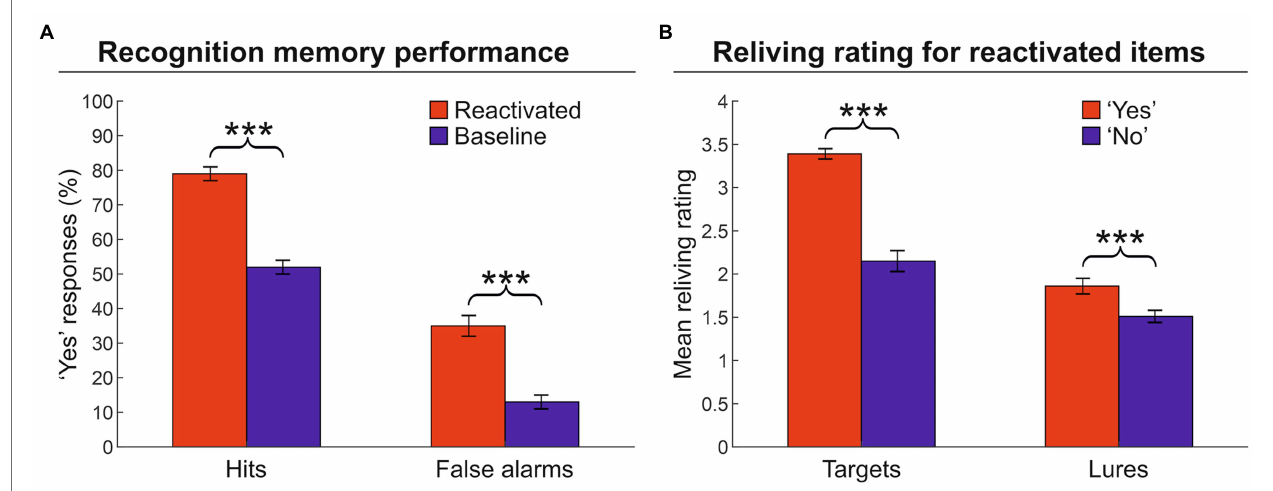
FIGURE 2 | Memory recognition performance and reliving ratings. (A) Proportion of “yes” responses (± the standard error of the mean) for reactivated and baseline targets. The graph shows that the reactivation procedure increased both hits and false alarms. (B) Mean reliving ratings (± the standard error of the mean) for reactivated items expressed during the memory reactivation phase. The graph shows that higher reliving ratings are associated with an increased probability to recognized the artwork (target or lure) as an item encountered during the museum tour (i.e., a “yes” response). *** p <